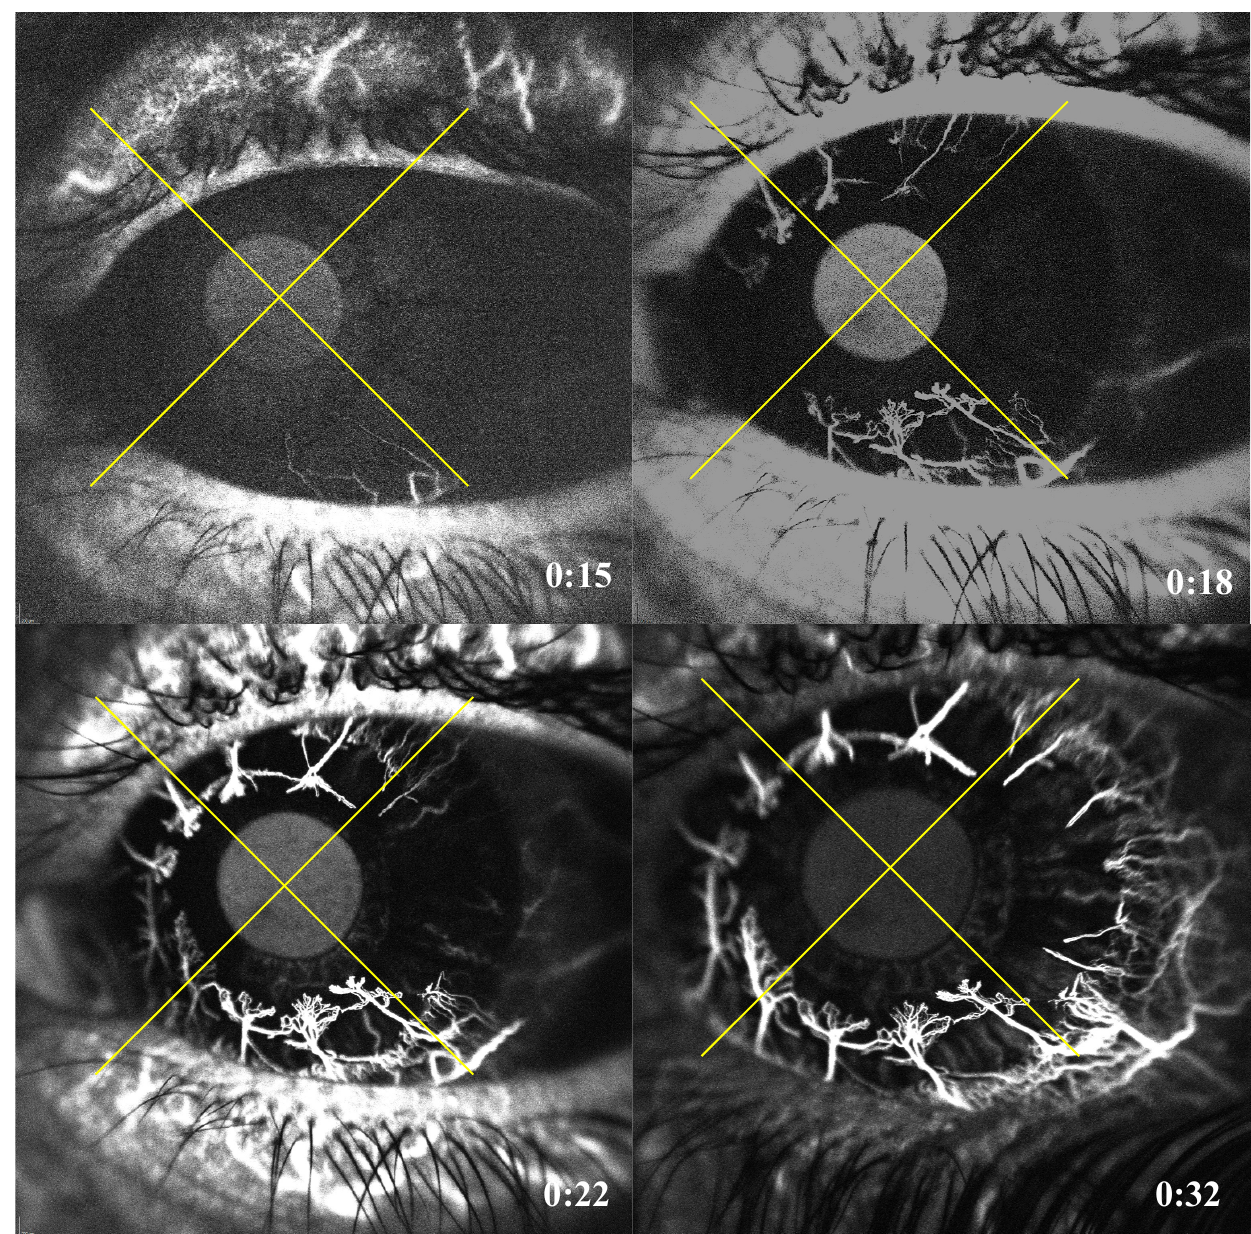
Figure 2. Indocyanine angiography showing a corneal neovascularization following the ISNT rule. The patient had a left eye penetrating keratoplasty that was followed by intensive 360° neovascularization. ( Top left ) shows that the first quadrant to fill is the inferior at 15 s, followed by ( top right ) the superior quadrant at 18 s, then the nasal quadrant at 22 s ( bottom left ) and ultimately the temporal quadrant at 32 s ( bottom right ).